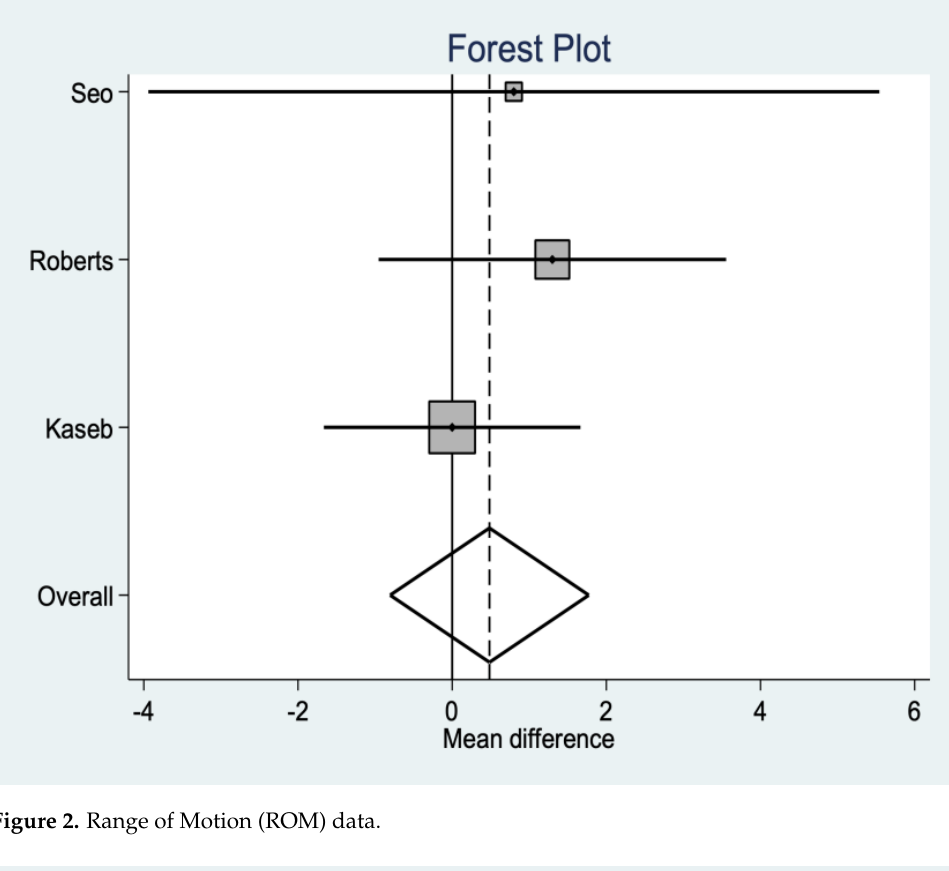
Figure 2. Range of Motion (ROM) data. Figure 2 . Range of Motion (ROM) data.